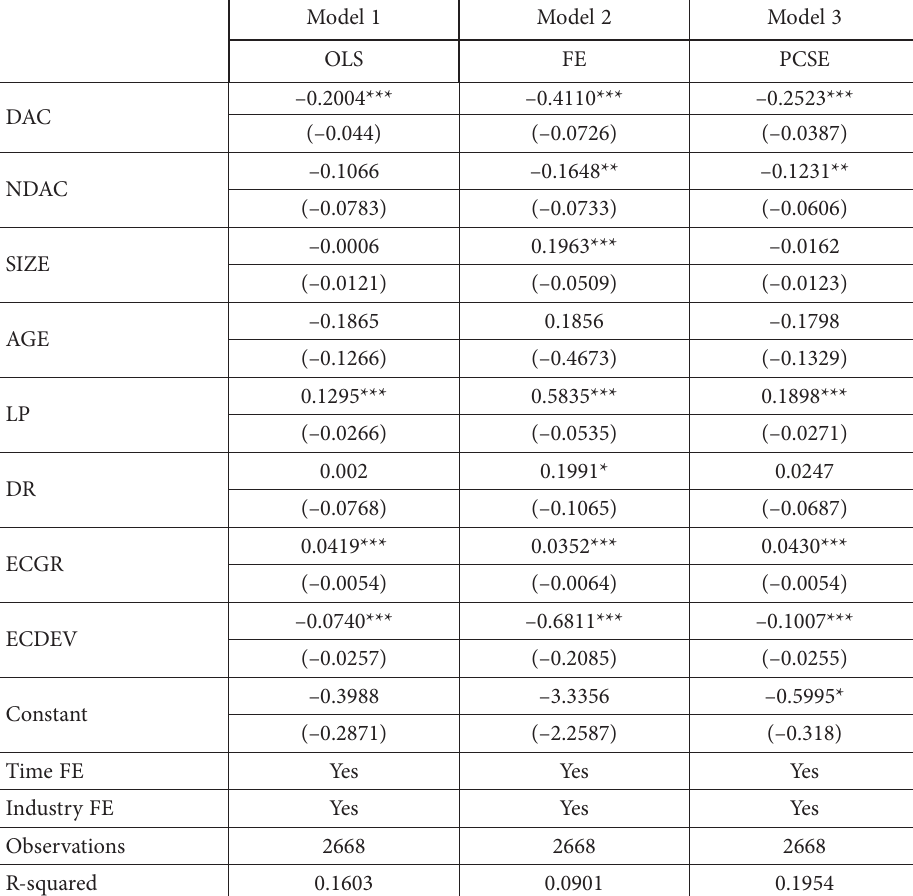
Table 5. Empirical results for the post-high-growth period